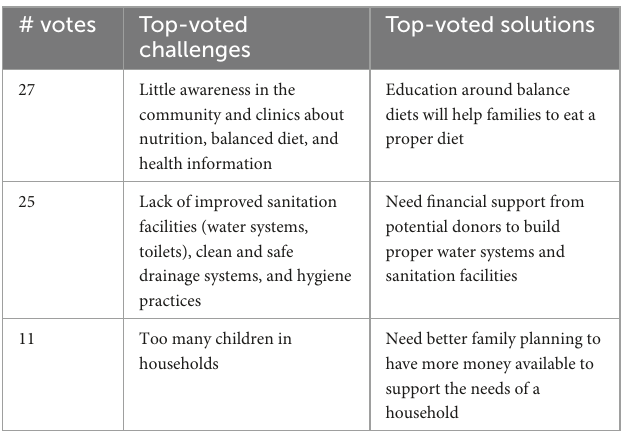
TABLE 6 Challenges and solutions for improving infant and child nutrition in Kola’a (urban).